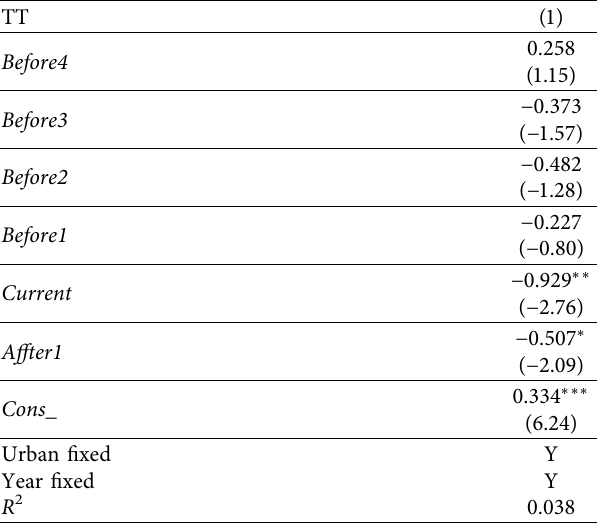
Figure 4: Parallel trend test. Horizontal axis representing the years before and after implementation and the vertical axis representing the magnitude of the coefficient estimates. Table 3: Parallel trend test regression